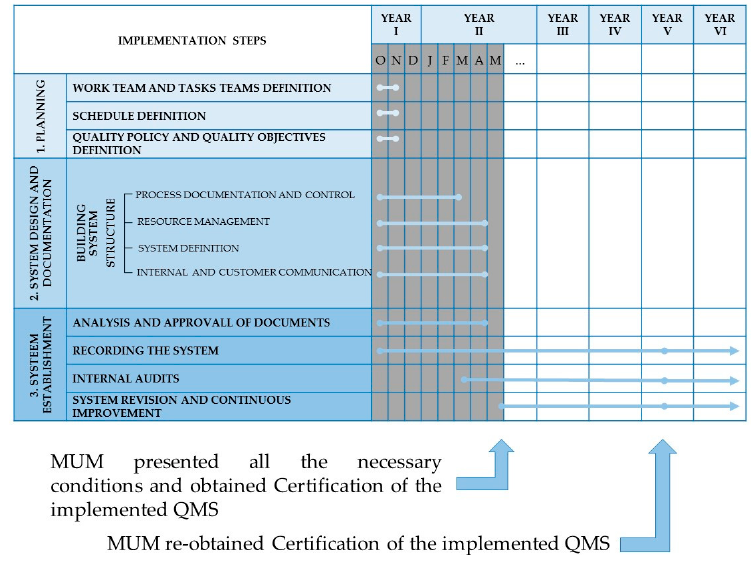
Figure 1. Timeline of the different phases from the implementation steps (grey area) until current state of the Quality Management System of the Micoteca da Universidade do Minho (MUM). The blue lines in bold represent the duration of the item during the represented timeline. The grey columns represent the time previous to certification. O, N, D, J, F, M, A and, M, under year I and year II, correspond to the months.